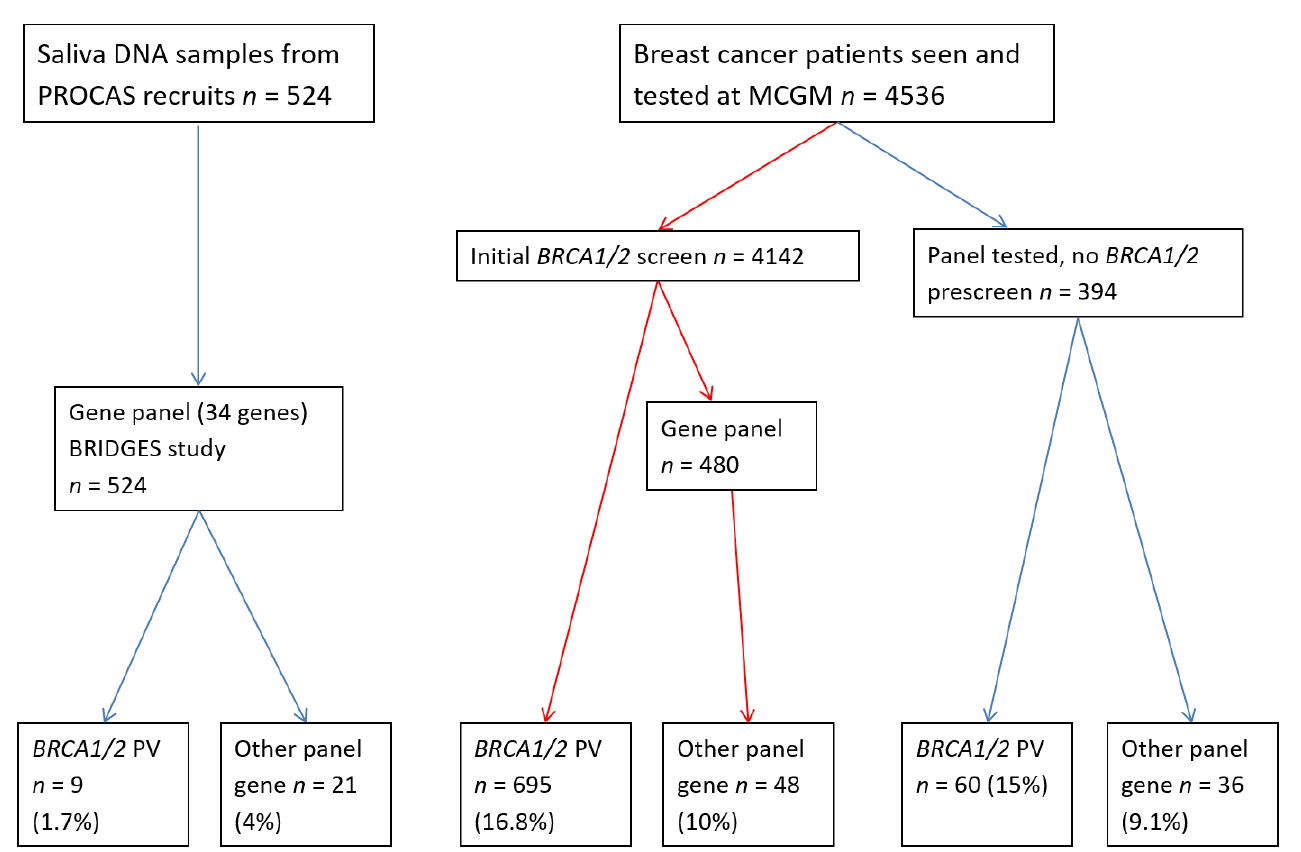
Figure 1. Flow chart showing selection of samples for panel testing.